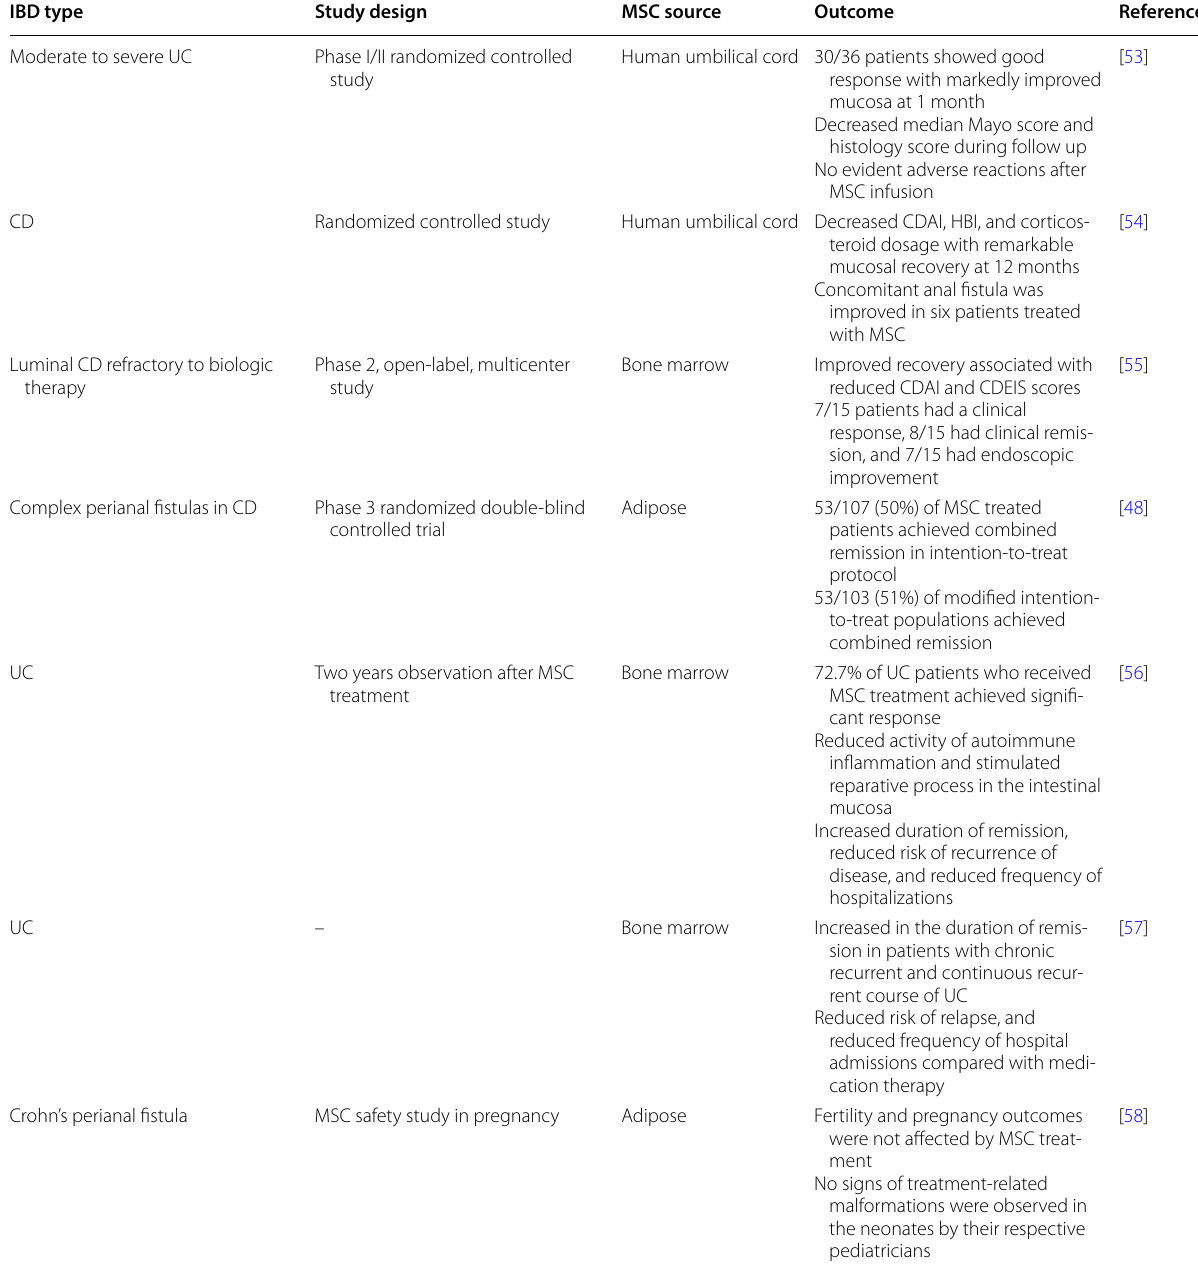
Table 2 Application of MSC-based therapy in IBD clinical